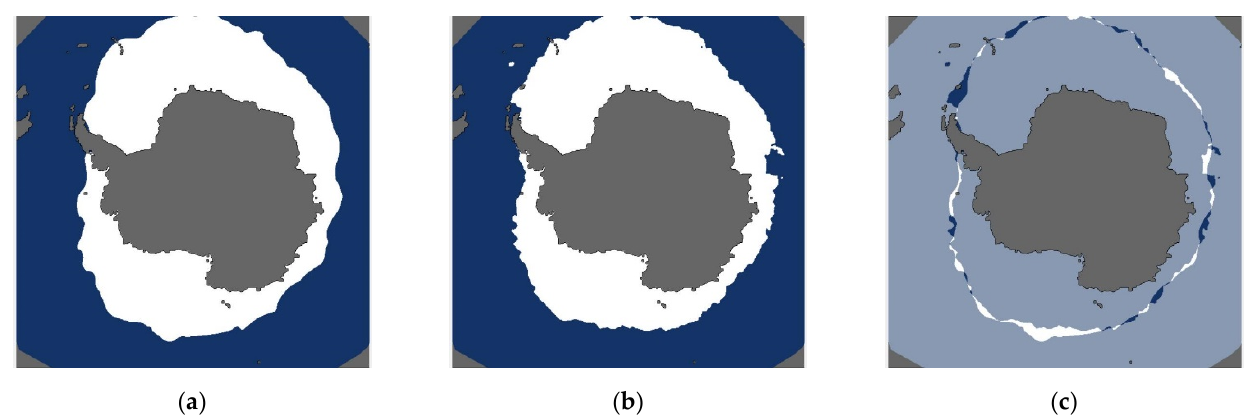
Figure 16. SIE Arctic composites using MWR data from 6 November to 8 November. ( a ) FMPL-2 MWR map, ( b ) Ground truth map, ( c ) Error map.